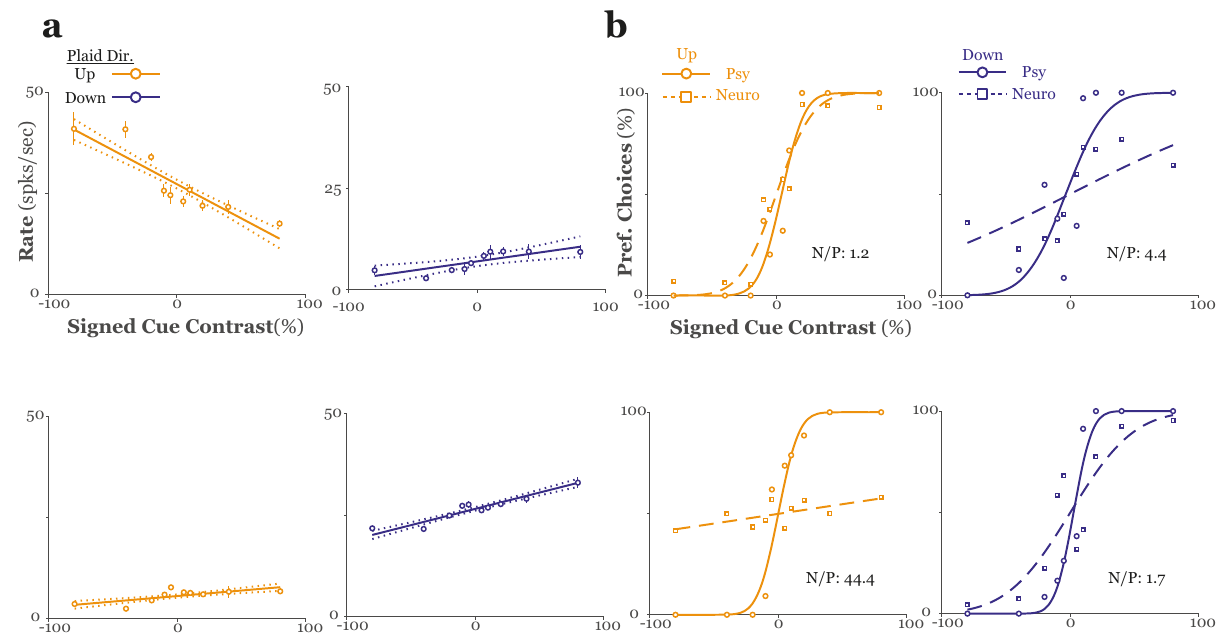
Fig. 4 | Quantifying MT responses to textured plaids. a Firing rate is plotted againstsignedtexturecontrastseparatelyforplaidsdriftingeitherup(left)ordown (right), solid lines are best fi t linear regressions, data in the top (bottom) rows are from the unit shown in Fig. 3a, b (Fig. 3c, d). The sign of the regression slope was used to assign a preferred texture cue (coherent/transparent) for each unit/plaid direction combination ( n ≥ 20 trials for each stimulus condition). Error bars representstandarderrorofthemean. b Neurometricfunctionsfortheunitsshown in a are depicted alongside psychometric functions collected during the same